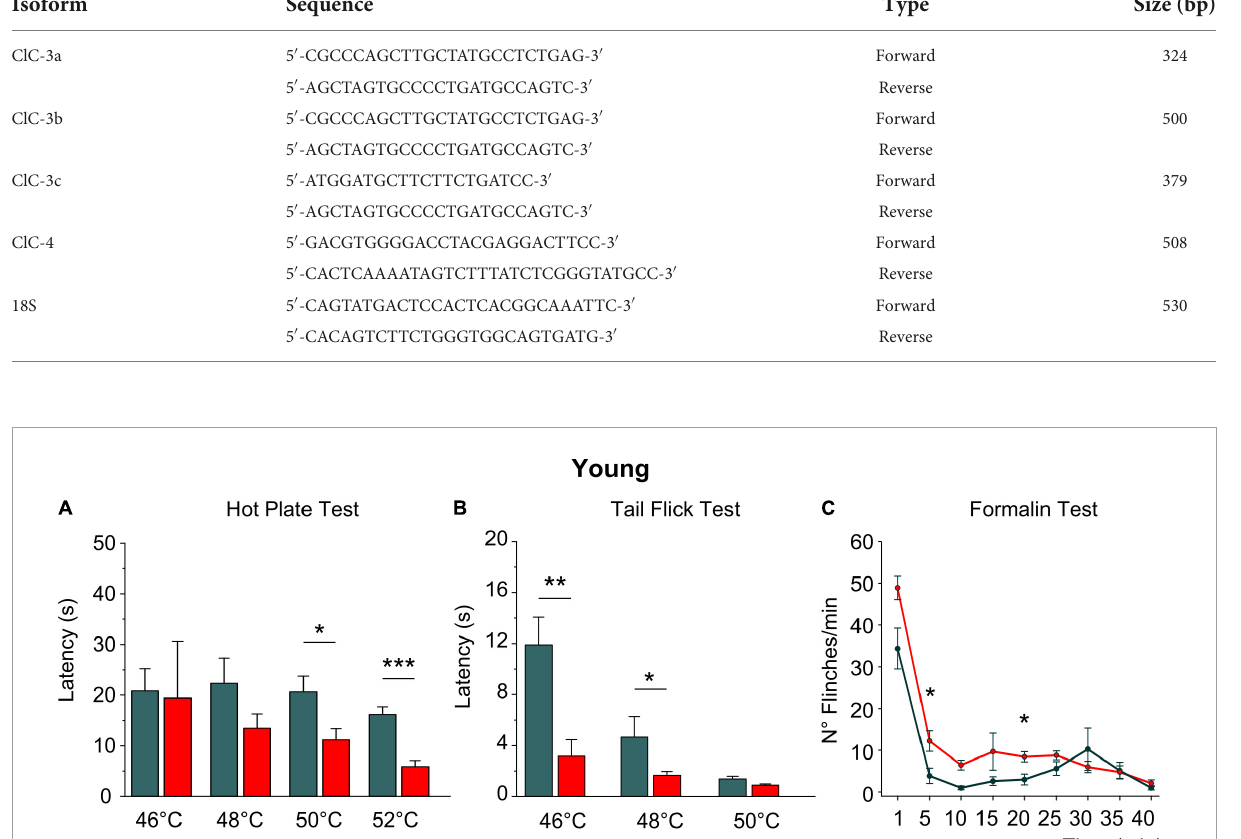
TABLE 3 List of primers used to identify the ClC exchangers in dorsal root ganglion (DRG). Isoform